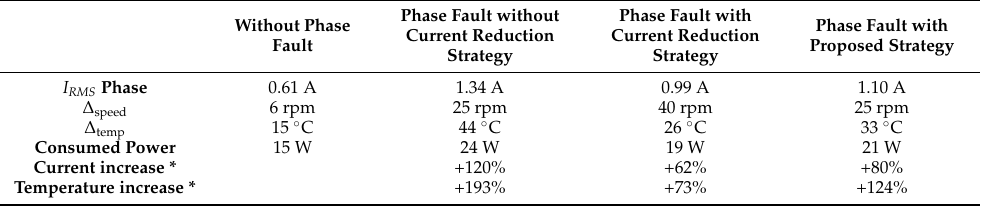
Table 3. Comparation Between the Operating Modes Presented.